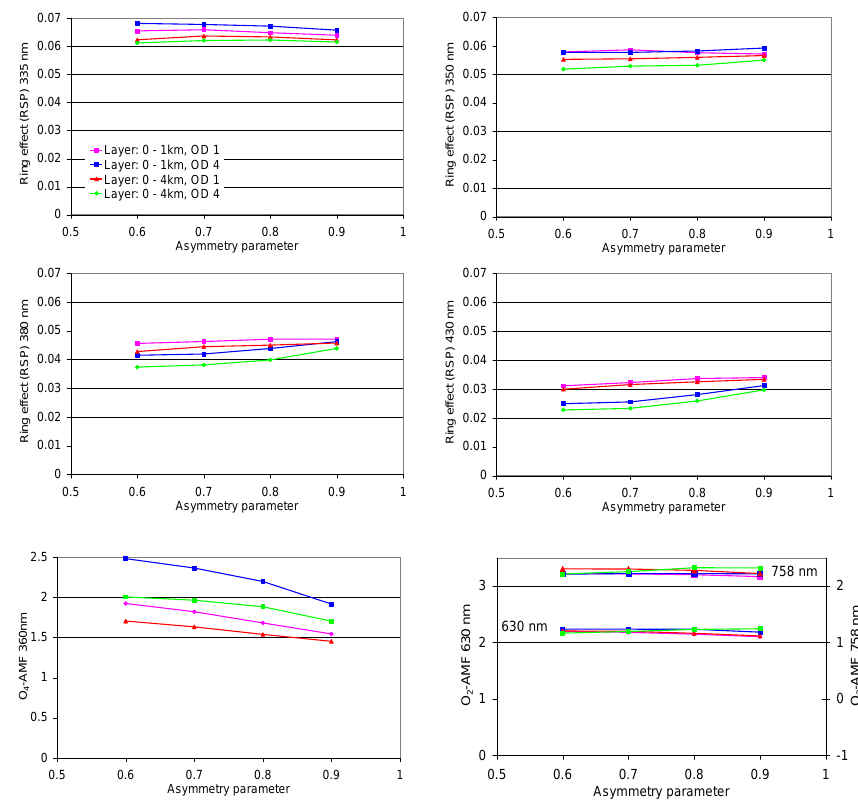
Fig. 18 Dependence of the Ring effect and the O 2 and O 4 absorptions on the aerosol asymmetry parameter g. The calculations are performed for aerosol single scattering albedo of 1, SZA of 30°, and a viewing angle of -90° (nadir geometry). For 758 nm the surface albedo was set to 20%, for 630 nm to 10%, and for all other wavelengths to 5%.